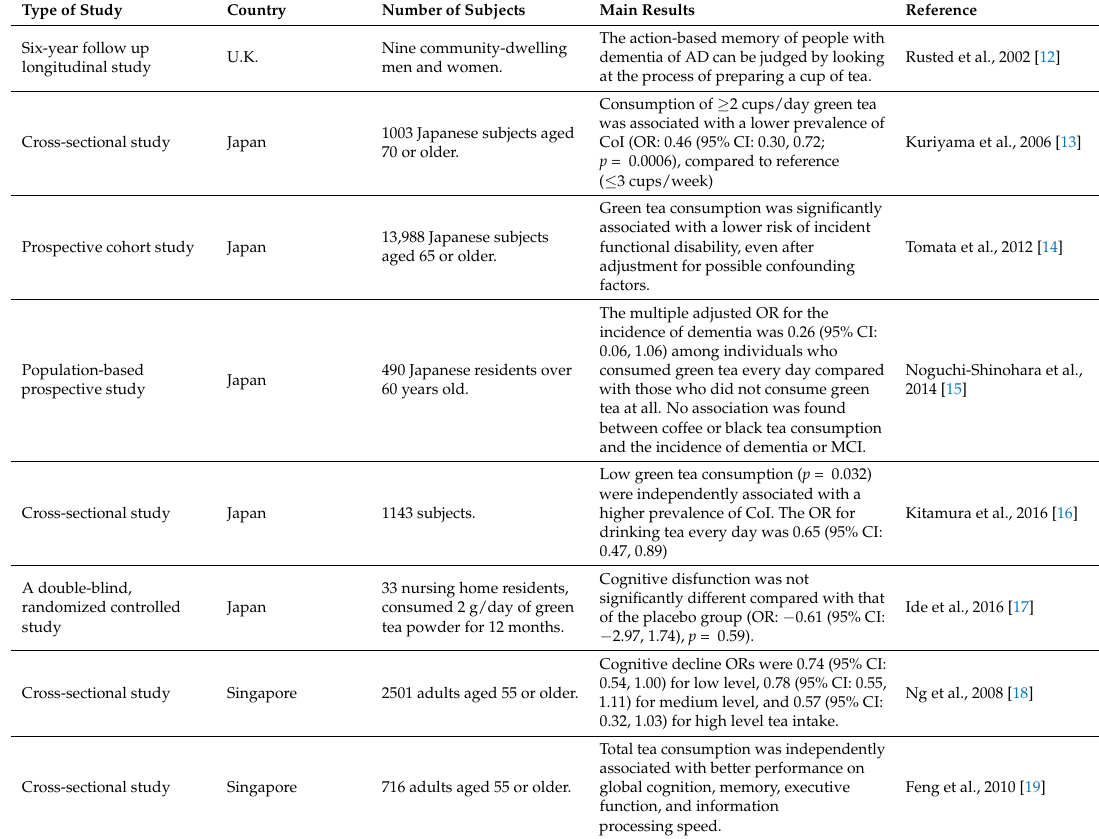
Table 1. Epidemiological evidence for the association between tea intake and the risk of Alzheimer’s disease (AD) and related cognitive